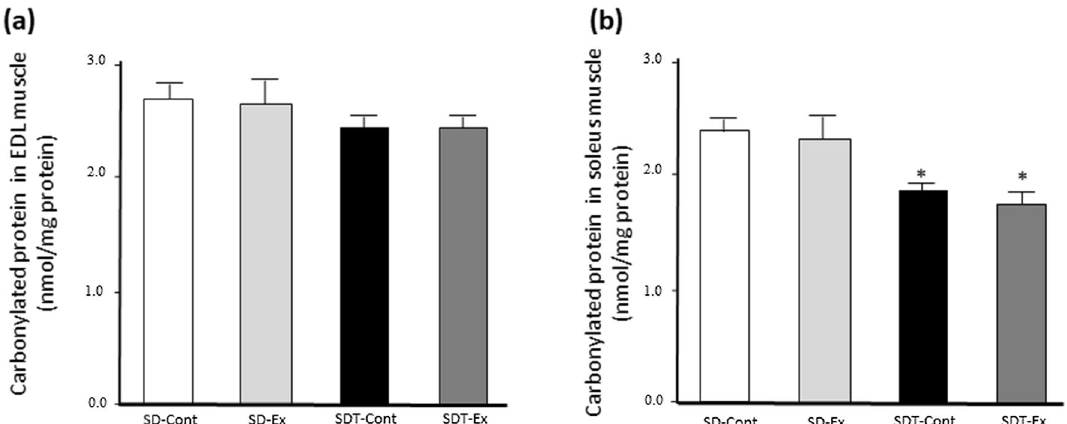
Fig. 9 Carbonylated protein in the extensor digitorum longus (EDL) and soleus muscles. Carbonylated protein in EDL ( a ) and soleus ( b ) muscles. Values are presented as mean n 6. * P < 0.05 vs. the SD‑Cont group =